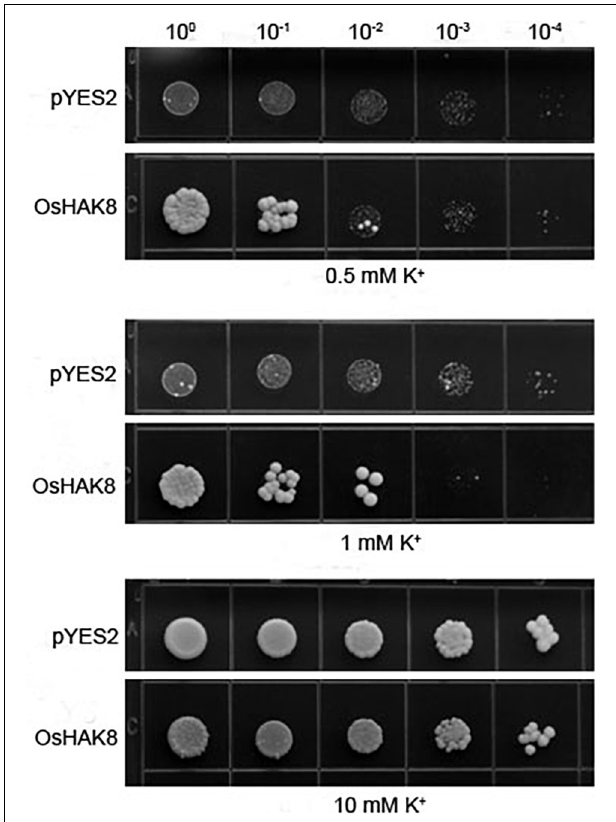
FIGURE 3 | Functional complementation of OsHAK8 in the K + uptake-deficient mutant strain CY162 of Saccharomyces cerevisiae . Growth of yeast strains on arginine phosphate (AP) medium containing different K + concentrations. The strains are CY162 cells transformed with the pYES2 vector only (pYES2), OsHAK8 cDNA in the pYES2 vector (OsHAK8). CY162 cells which harbored pYES2 or expressed OsHAK8, were grown on the AP medium containing 0.5, 1, or 10 mM of K + . No significant differences were found between pYES2 and OsHAK8 when grown on the AP medium containing 10 mM of K + ( P >0.05 by Student’s t -test). Significant differences were found between pYES2 and OsHAK8 when grown on the AP medium containing 0.5 mM K + ( P <0.01 by Student’s t -test). The experiment was repeated three times with similar